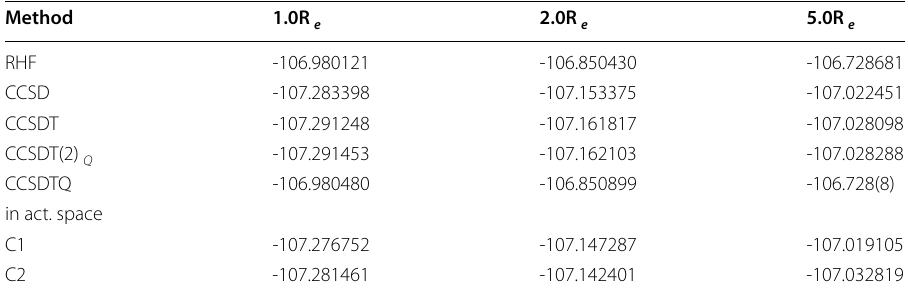
Table 1 A comparison of the CC energies obtained for the LiF model in the cc-pVTZ basis set (see text for more details) with C1 and C2 energies obtained in the active space defined by the 13 lowest- lying RHF